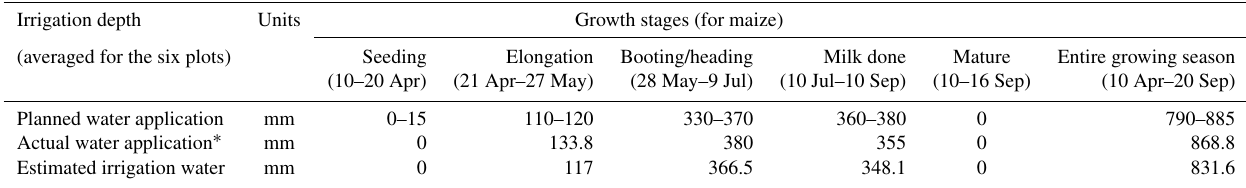
Table 1. Planned and actual application of irrigation water for the plots during the growing season of 2016. Irrigation depth Units Growth stages (for maize) (averaged for the six plots) Planned water application